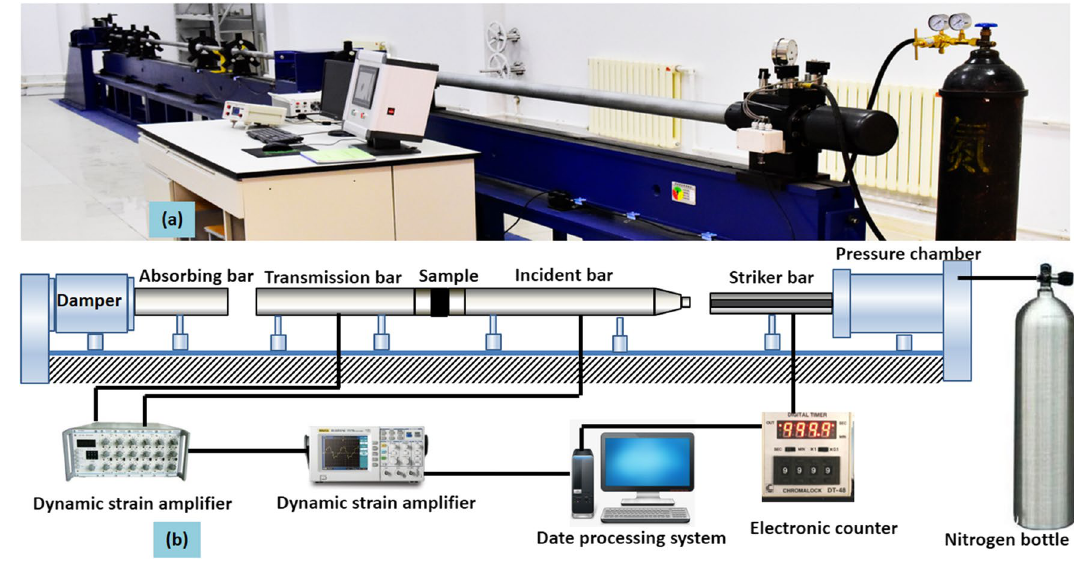
Fig. 1 Split Hopkinson pressure bar test apparatus. a Photo of SHPB apparatus; b Schematic diagram of SHPB apparatus